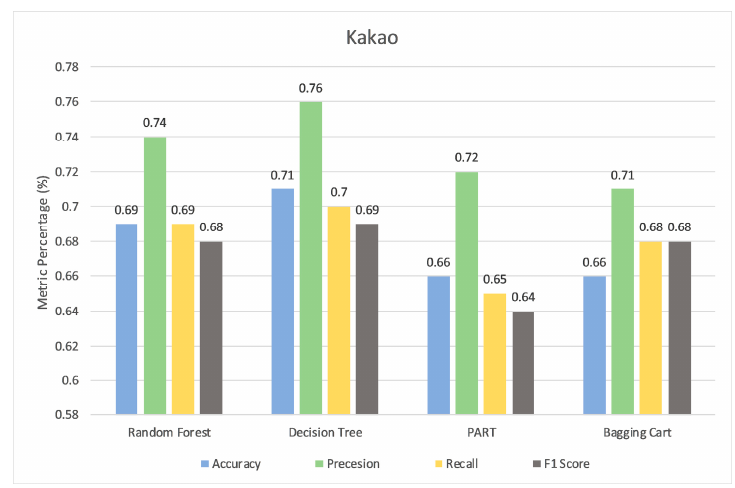
Figure 8. Evaluation result on Kakao.